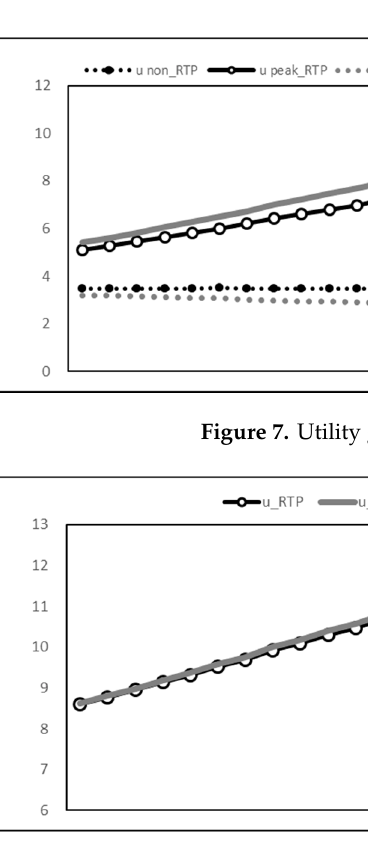
Figure 8. Total utility graph.